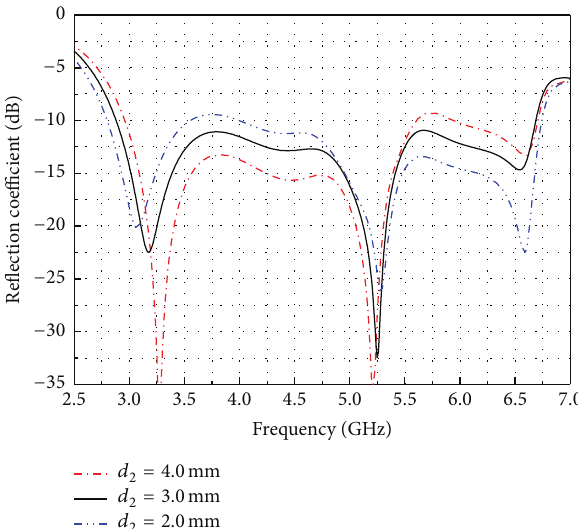
Figure 7: Simulated reflection coefficient with different values of 𝑑 2 ( 𝑑 1 = 23.0 mm, ℎ 1 = 6.0 mm, ℎ 2 = 15.0 mm, ℎ 3 = 10.0 mm, 𝑊 1 = = 2.0 mm, 𝐿 = 4.5 mm, and 𝐿 = 2.5 mm). 13.0 mm, 𝑊 2 1 2